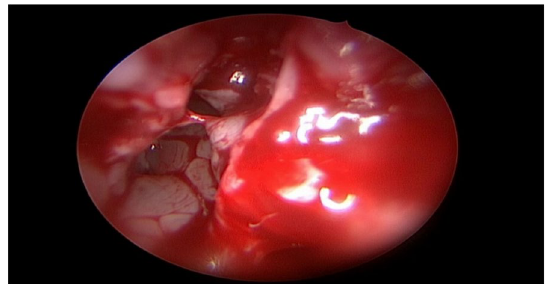
Fig. 2 Frontal ostium